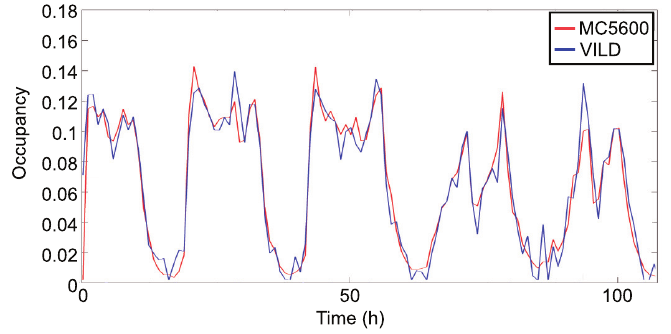
Figure 12. Traffic occupancy with 60 samples per hour.